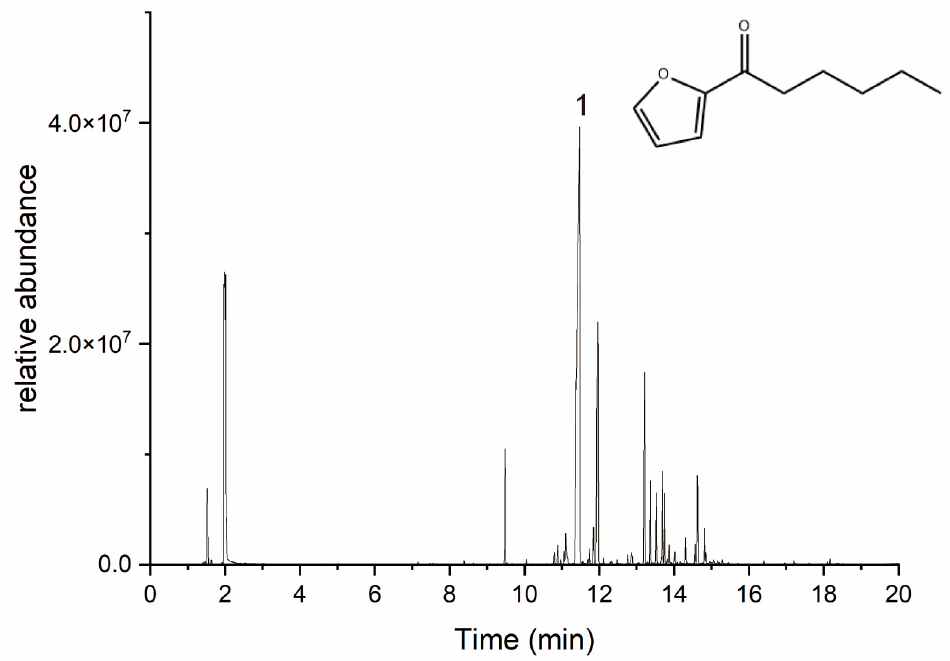
Figure 1. Gas chromatography–mass spectrometry chromatogram of perilla essential oil and the structure of the main component 2-hexanoylfuran. Table 1. Chemical components of the essential oil extracted from Perilla frutescens leaves. Peak No.